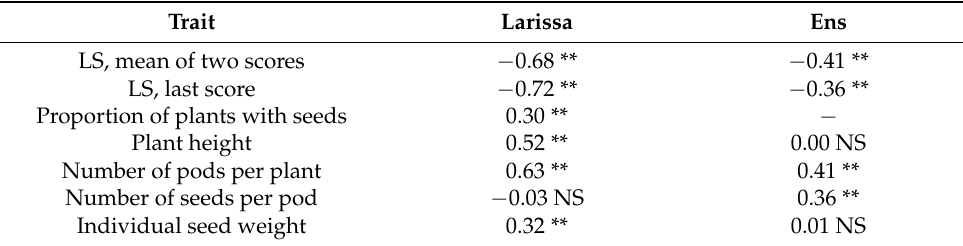
Table 3. Phenotypic correlation of grain yield with a visual lime susceptibility (LS) score and five other traits, for 140 white lupin inbred lines grown in Larissa (Greece) and Ens (the Netherlands). Trait Larissa Ens LS, mean of two scores − 0.68 ** − 0.41 ** LS, last score − 0.72 ** − 0.36 ** Proportion of plants with seeds 0.30 ** − Plant height 0.52 ** 0.00 NS Number of pods per plant 0.63 ** 0.41 ** Number of seeds per pod − 0.03 NS 0.36 ** Individual seed weight 0.32 ** 0.01